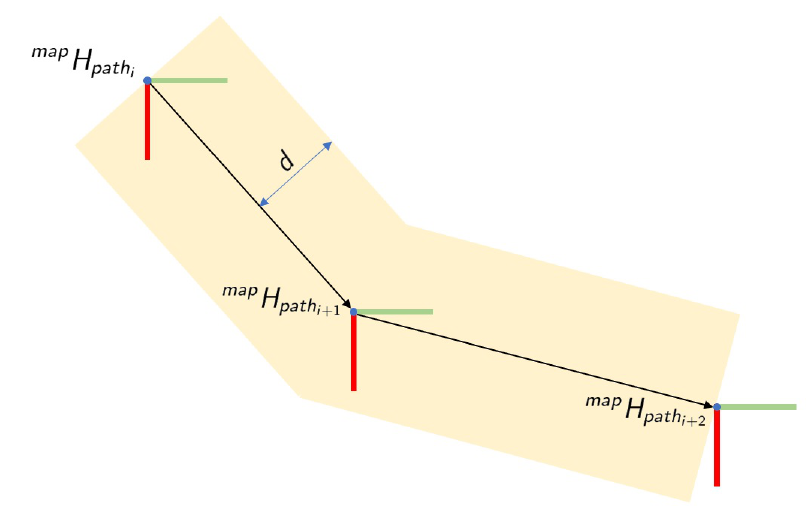
Figure 2. Definition of